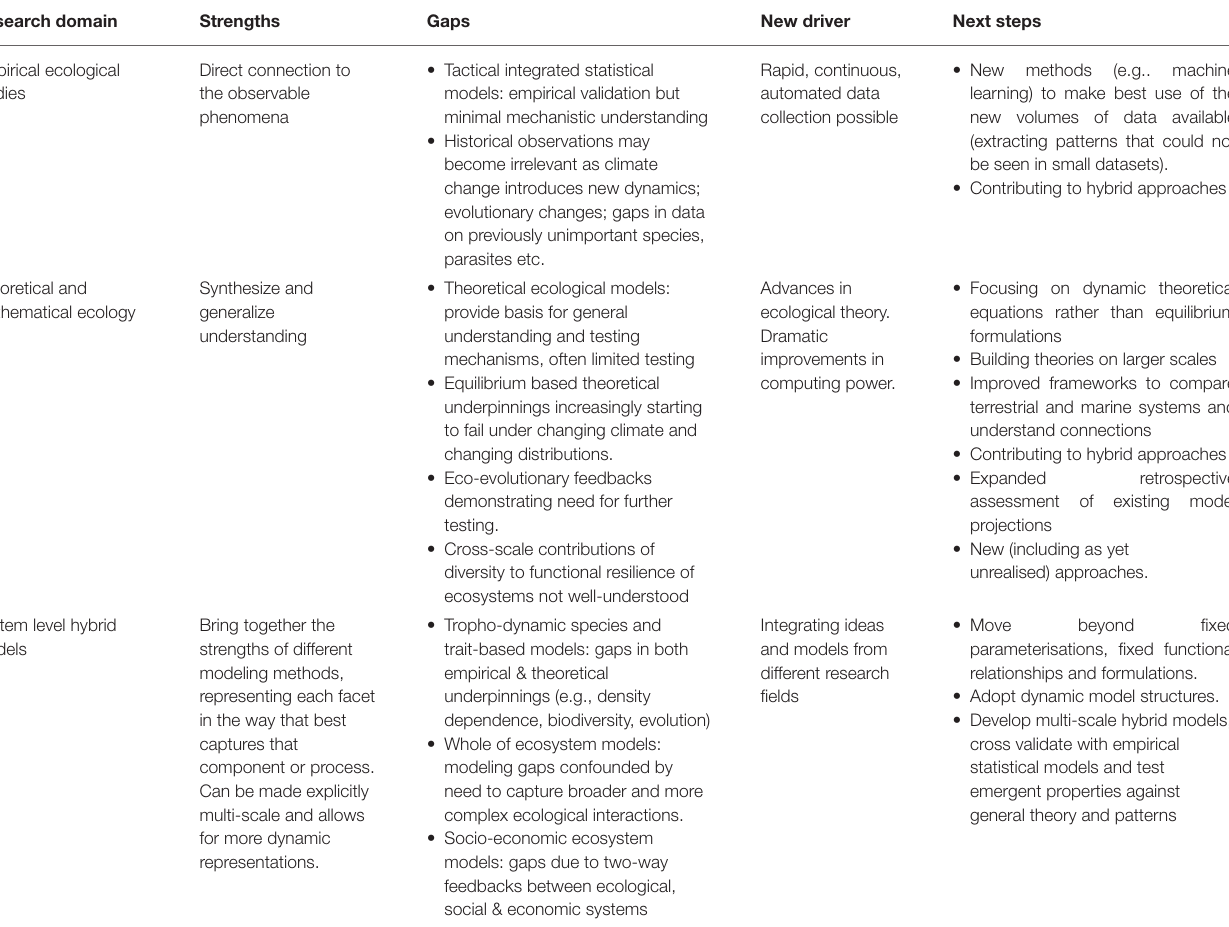
TABLE 1 | Summary of the strengths, gaps and drivers for change in empirical and theoretical ecology and modeling as perceived by the authors. Research